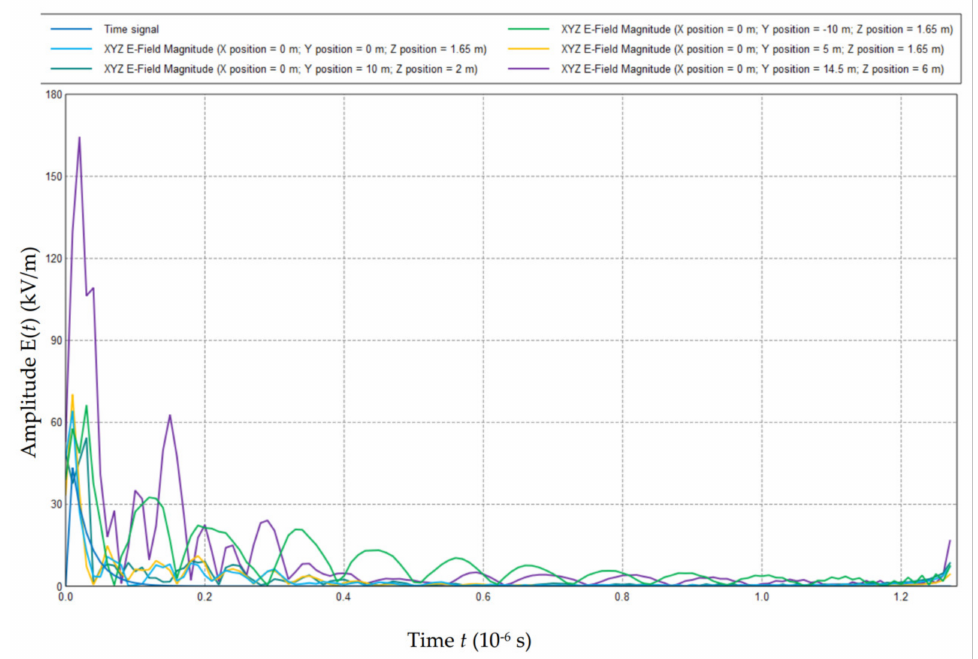
Figure 9. Tendencies of the electric field strength E ( t ) at various positions of top layer outside the